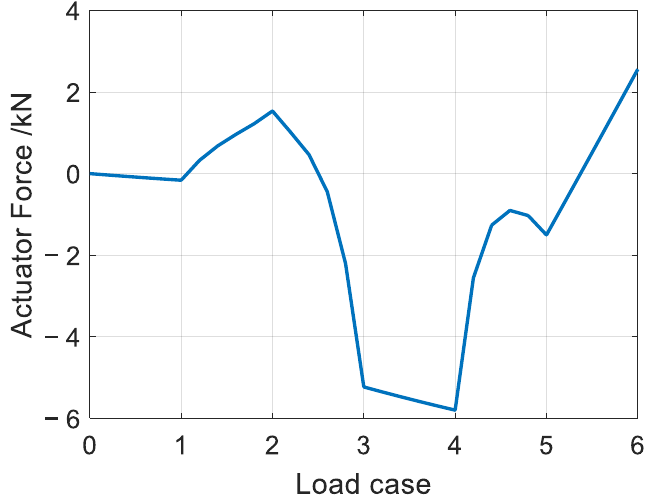
Figure 18. Actuation forces computed using the described FE model.